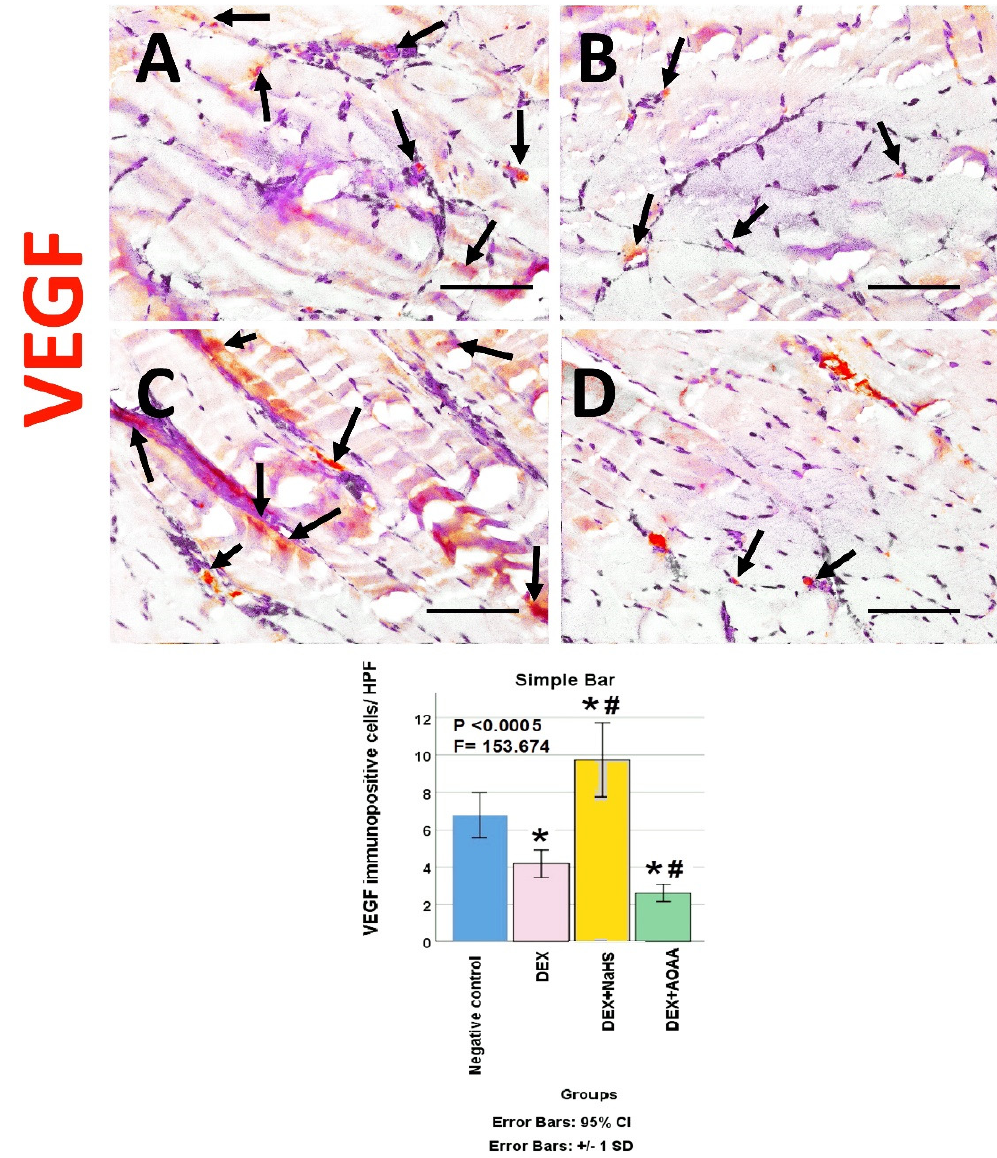
Figure 6. ( A – D ): Light-microscopic image of VEGF immunostaining ( × 400) in soleus muscle tissues of all studied groups; Negative control, Dex, Dex + NaHS, and Dex + AOAA groups ( A – D ; respectively). Scale bar = 25 µ m. Arrows: VEGF immunopositive cells. ( E ) The mean of the number of VEGF immunopositive cells/HPF in the studied groups. Results are mentioned as mean ± standard deviation. The test used: one-way ANOVA, followed by post-hoc Tukey test. p : significance (<0.05). *: significance as compared to the negative control group. #: significance as compared to (Dex) group. Dex: Dexamethasone, NaHS: Sodium hydrosulfide, and AOAA: Aminooxyacetic acid.